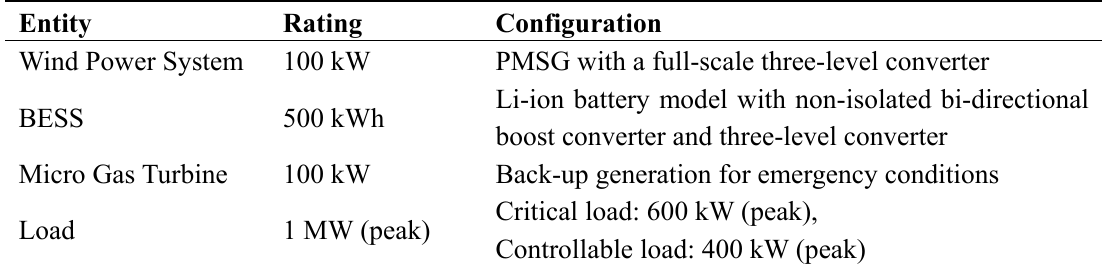
Table 1. Ratings of microgrid